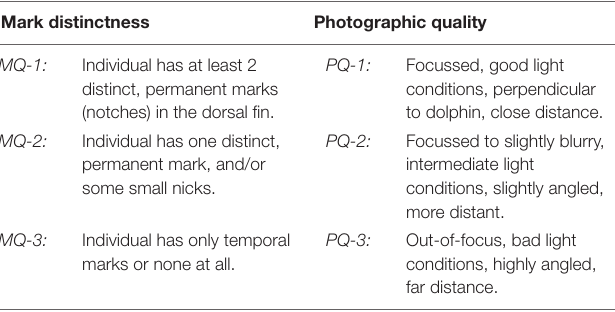
Mark distinctness Photographic